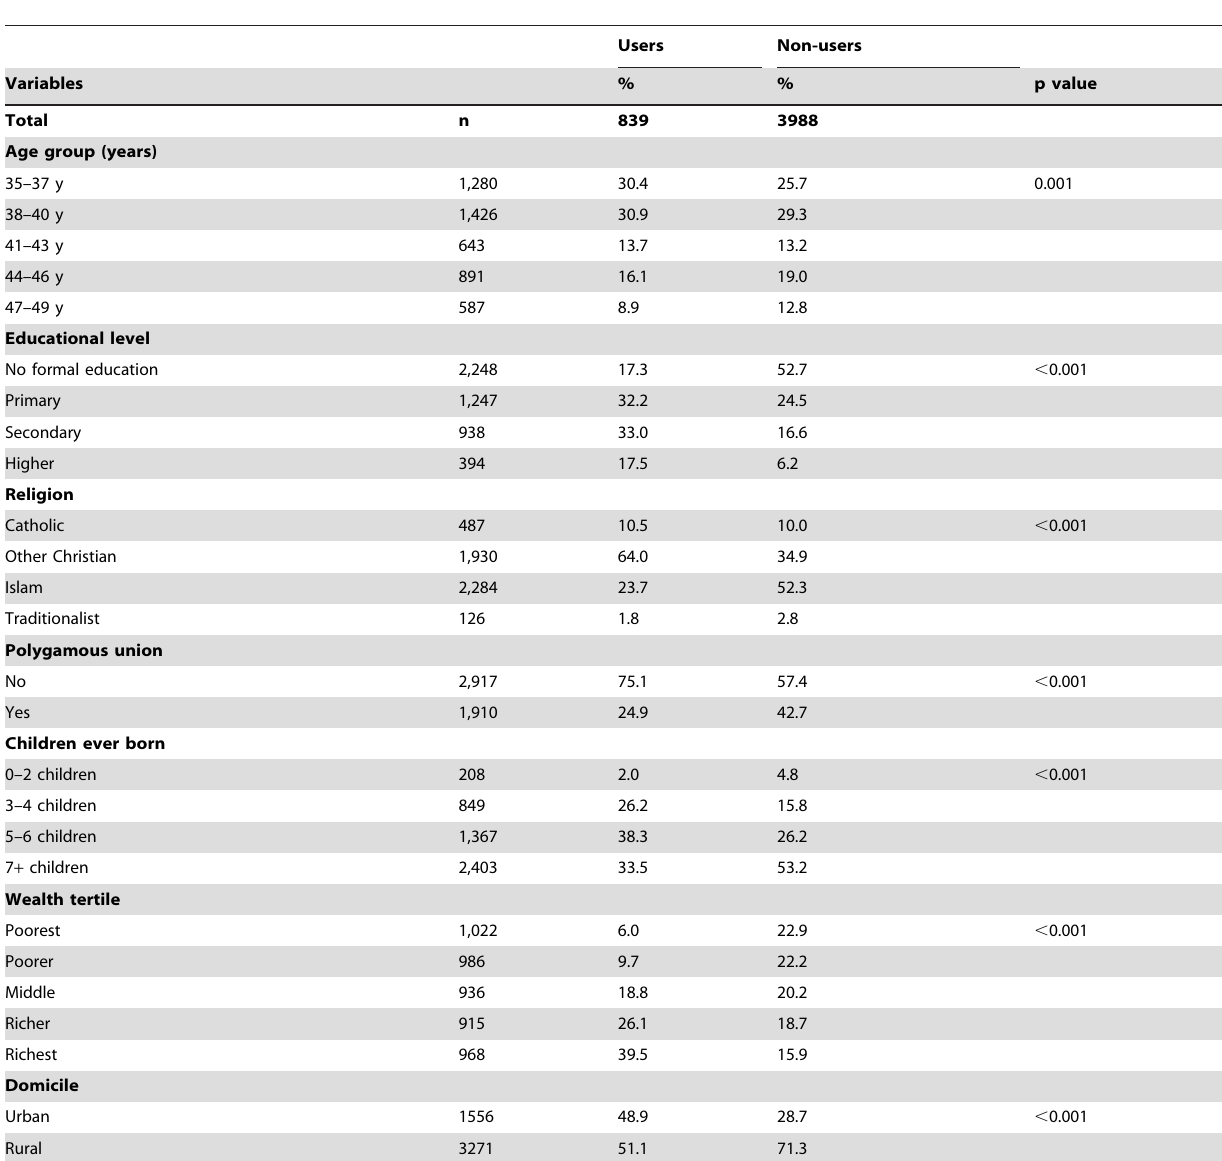
Table 1. Socio-demographic Profile of Nigerian Women by Current Modern Contraceptive Use